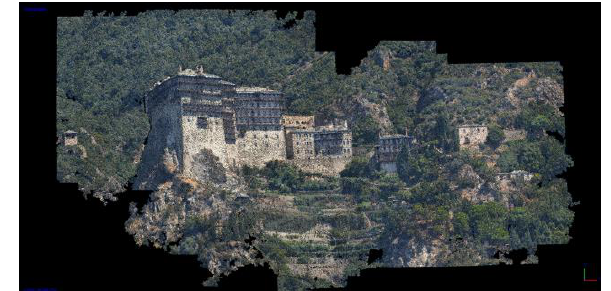
Figure 7 . The Monastery of Simonpetra. Cloud of points.